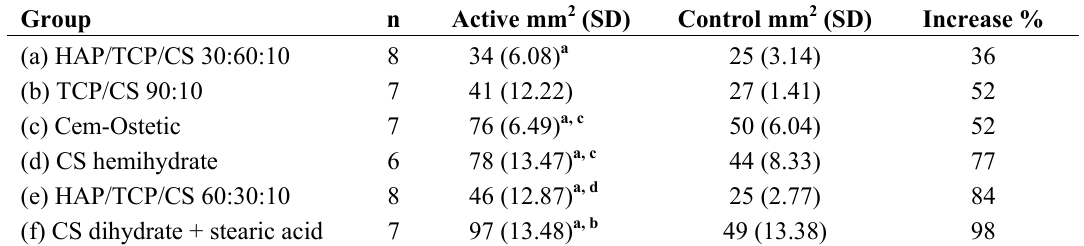
Table 1. Radiographic analysis of active implant containing the bone extract and control after 21-days follow-up (opalescent area in mm 2 ). The percent increase compared to the control is